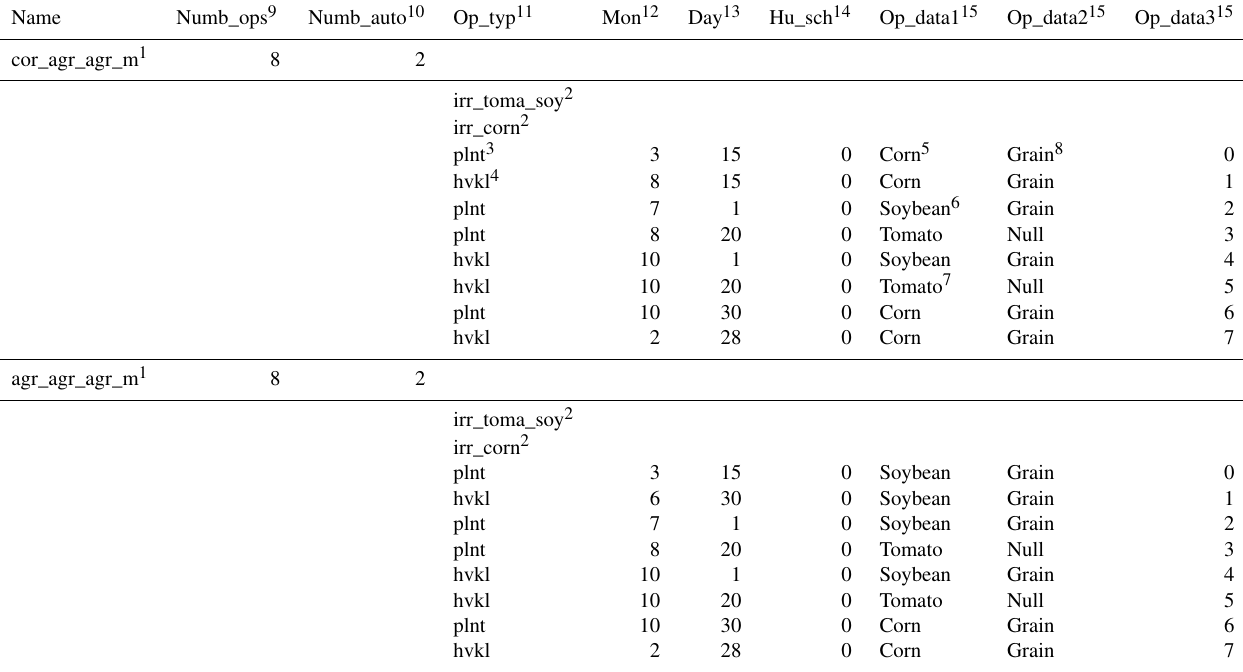
Table 1. An example of a management.sch file input in the dynamic SWAT +